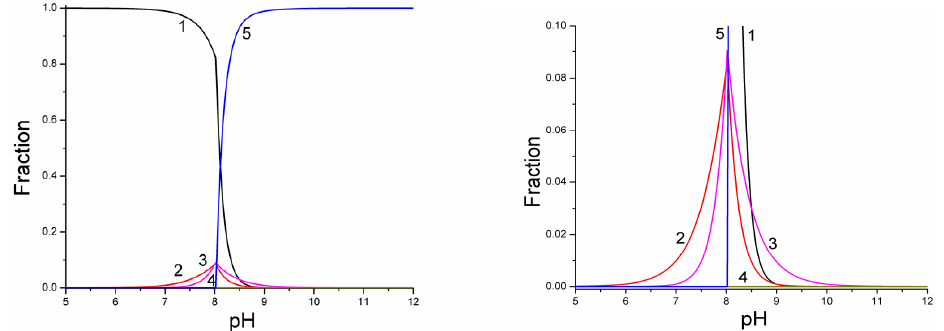
Figure 3. Dependence of the Pr(III) species fraction on pH (concentration of Pr(III), 7.09 × 10 − 6 M) (1, Pr 3+ ; 2, PrOH 2+ ; 3, Pr(OH) 2+ ; 4, Pr 2 (OH) 24+ ; 5, Pr(OH) 3 ).